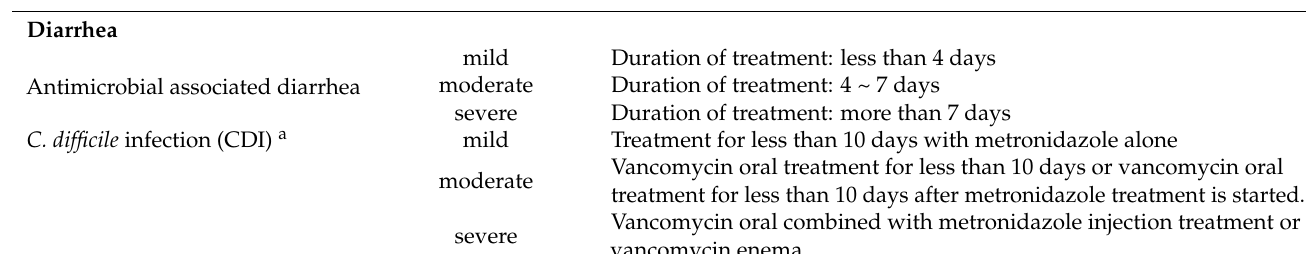
Table 4. Screening criteria of adverse events associated with antimicrobials.